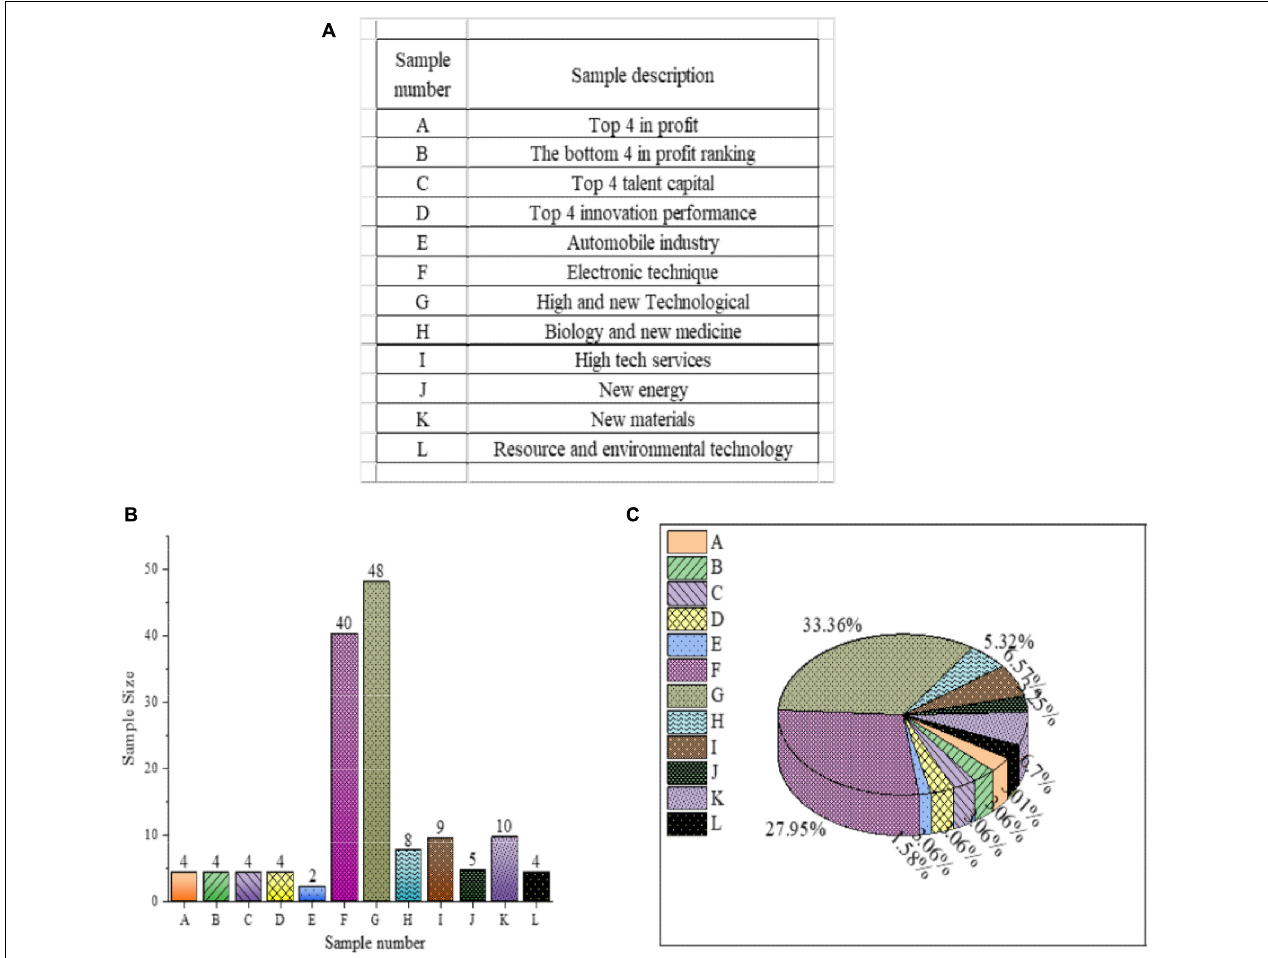
FIGURE 3 | Sample situation: (A) Sample description; (B) Sample size; (C) Proportion of sample.